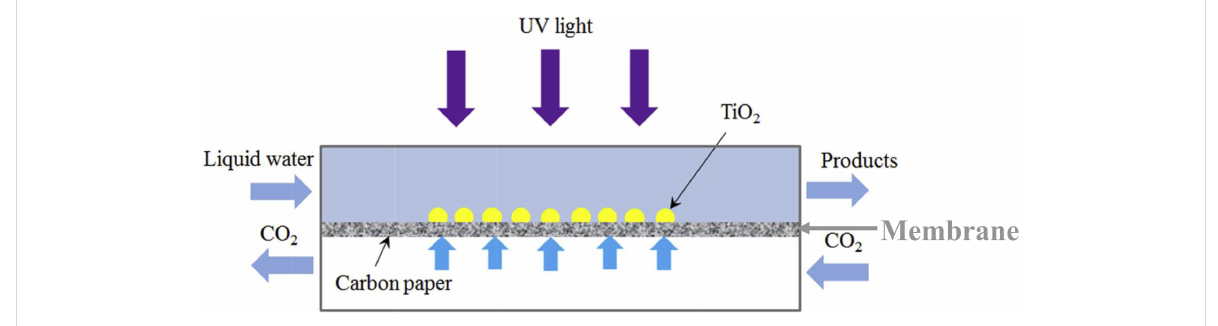
Figure 6: Schematic of the optofluidic membrane microreactor for photocatalytic CO 2 reduction. Adapted from [76], copyright 2016 Elsevier Ltd.